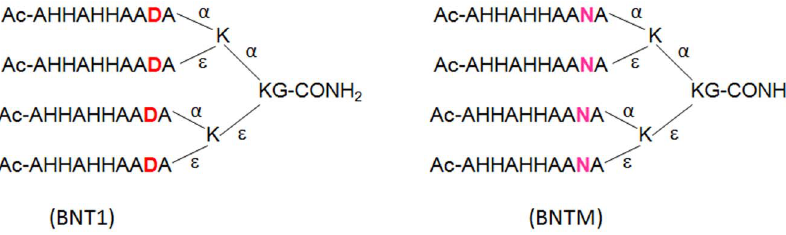
Figure 1. Sequence of dendrimeric peptides used in this study. All aspartic acid (D) residues of BNT1 have been substituted by asparagines (N) in BNTM. a and e denote amino groups of